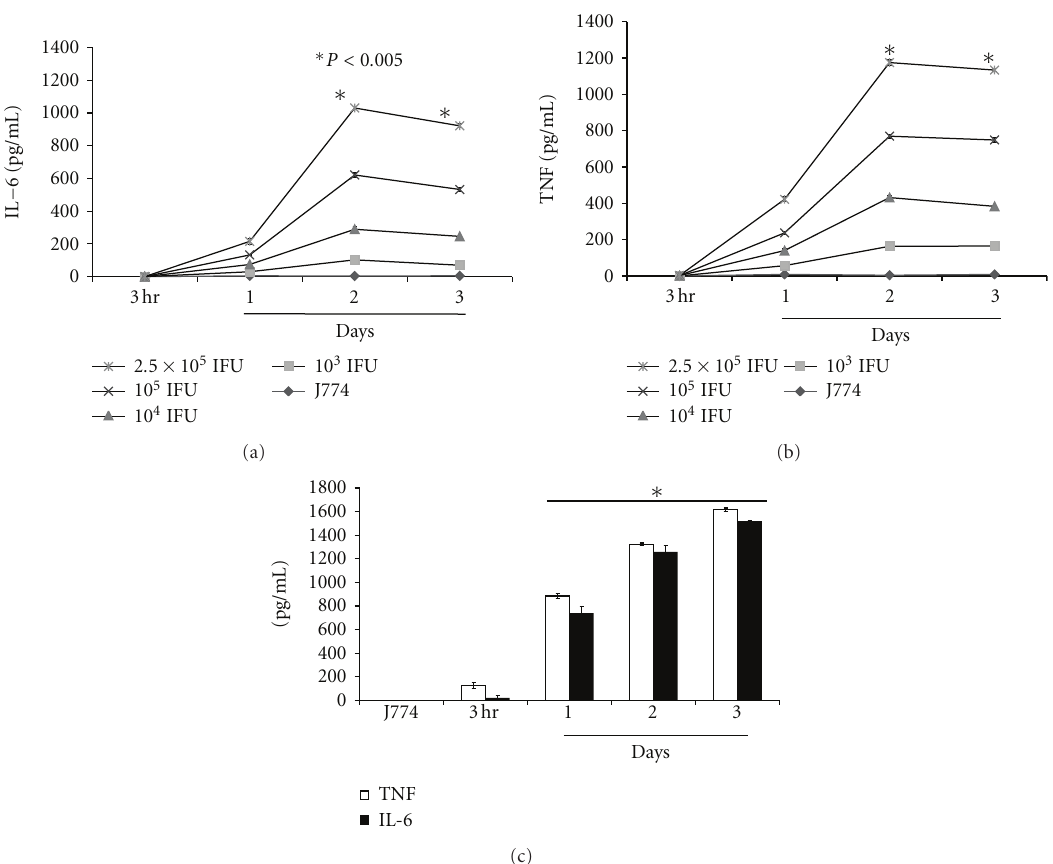
Figure 4: The production of IL-6 and TNF were induced in a time-dependent fashion in C. trachomatis- (CT-) infected mouse J774 macrophages. J774 cells (10 5 cells/mL/well) were seeded in 24-well plates. Twenty-four hours later, cells were infected with C. trachomatis EBs (10 4 IFU/well) and cell-free cultured supernatants were collected at di ff erent time-points. The levels of IL-6 (a) and TNF (b) were measured in supernatants by cytokine-specific ELISA. For positive control, J774 cells (10 6 cell/mL) were stimulated with LPS (1 μ g/mL) (c) for various time-points. Asterisk indicates significant di ff erence ( P < 0 . 005), and P values were calculated by use of Student’s t- test. Each bar represents the mean ± SD of samples run in duplicates. The data are representative of two separate